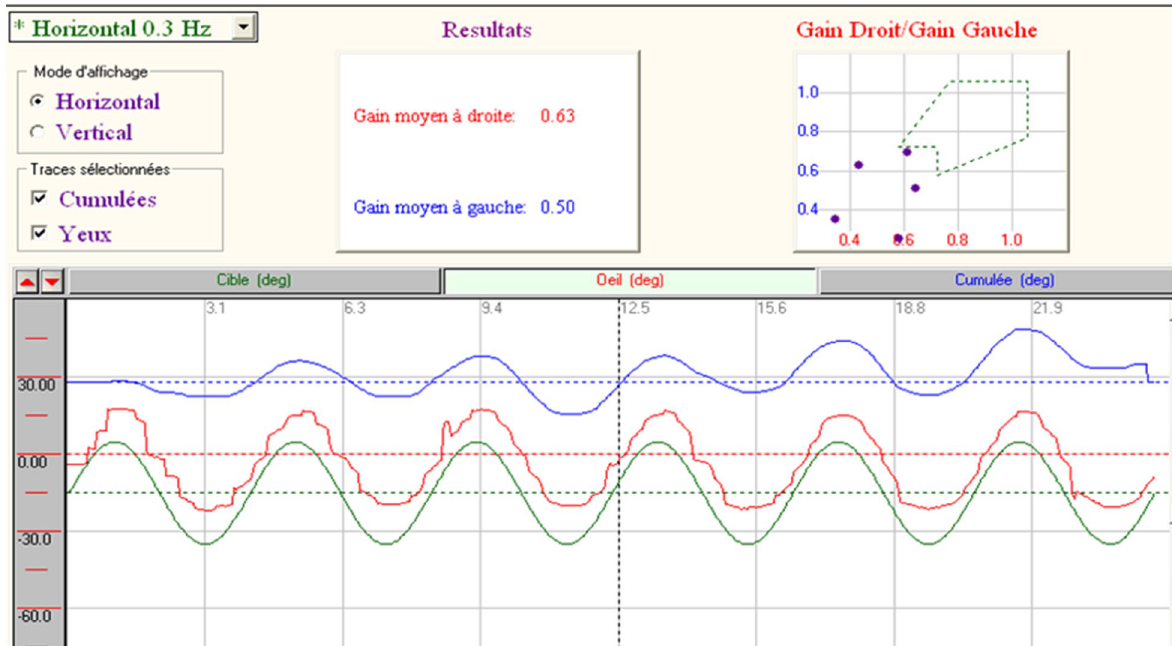
Fig. 4 Pathologic tracking test with low gain of pursuit movements and saccadic events (green graph, target movement; red graph, eye saccadic